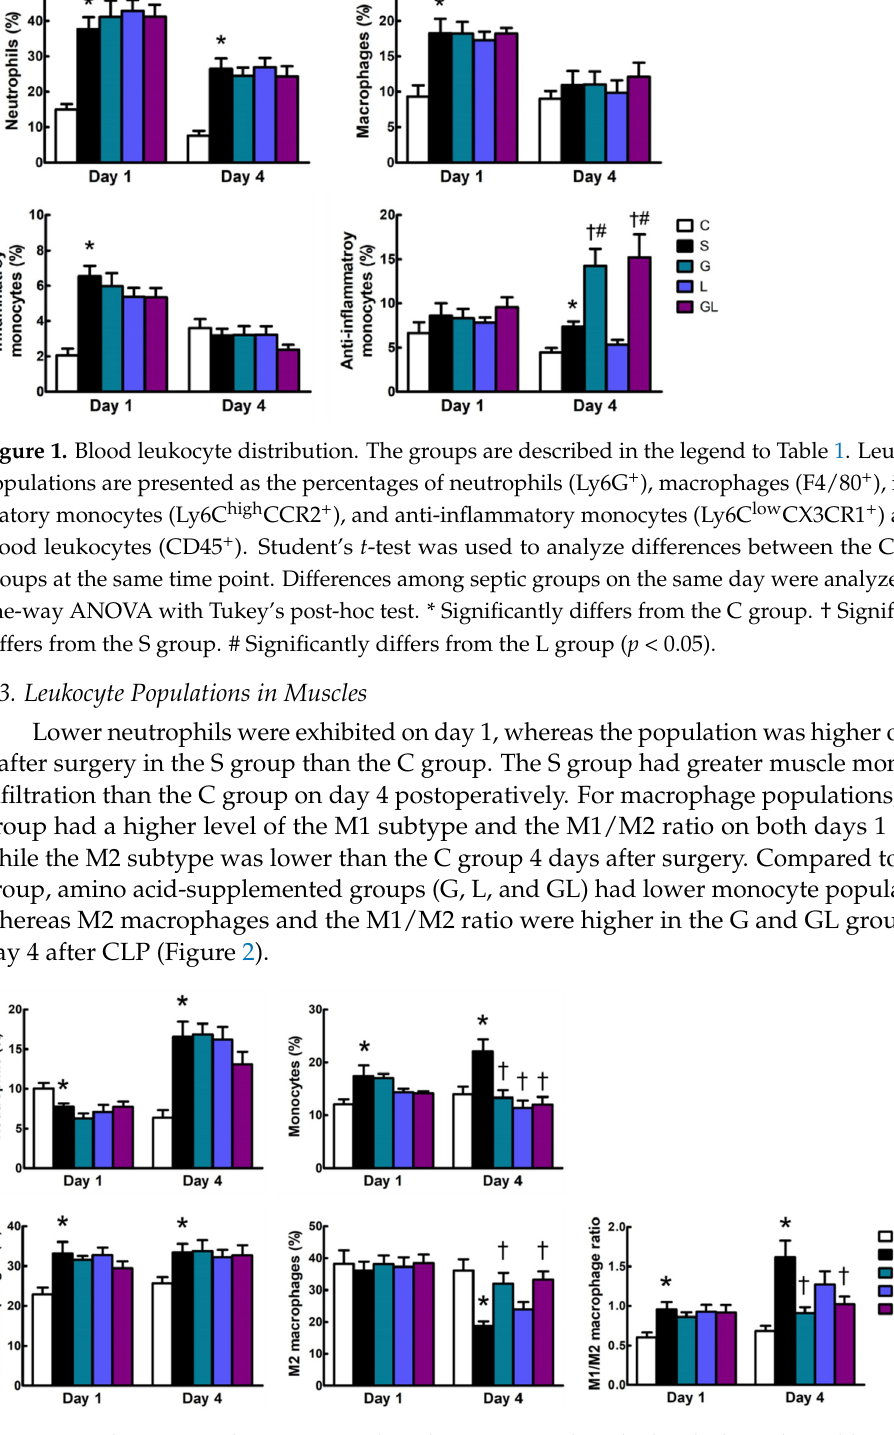
Figure 2. Leukocyte populations in muscles. The groups are described in the legend to Table 1. Leukocyte populations are presented as the percentages of neutrophils (Ly6G + ), monocytes (Ly6C high ), M1 macrophages (F4/80 + CD206 - ), and M2 macrophages (F4/80 + CD206 + ) among leukocytes (CD45 + ). The M1/M2 macrophage ratio was also demonstrated. Student’s t -test was used to analyze differences between the C and S groups at the same time point. Differences among septic groups on the same day were analyzed by a one-way ANOVA with Tukey’s post-hoc test. * Significantly differs from the C group. † Significantly differs from the S group ( p <